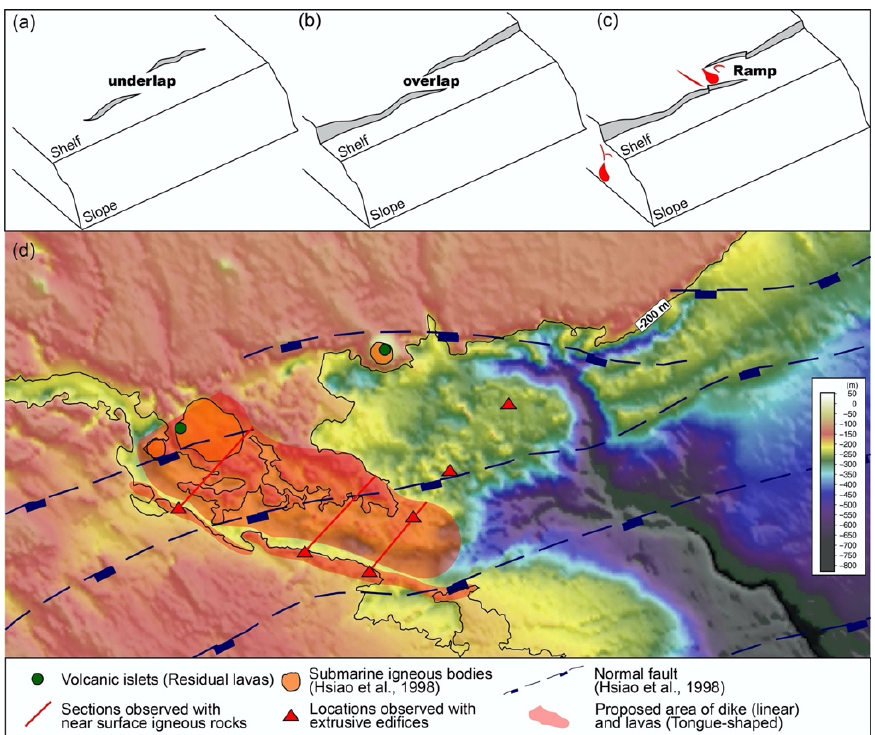
Figure 11. Development of a relay ramp via the approaching ( a ), passing ( b ), and overlapping ( c ) of the fault tips. The red rectangle in ( d ) indicates the area of possible and associated volcanic fea- tures.